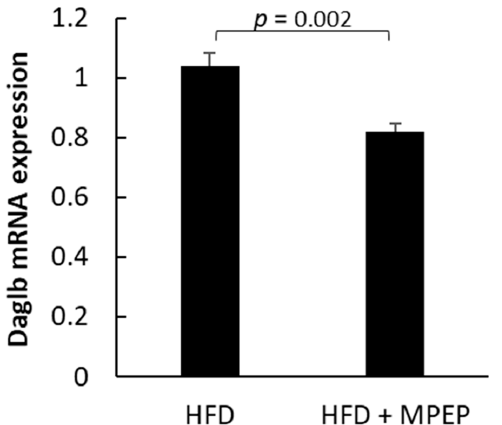
Figure 11. Hepatic stellate cell activation in obese mice. Daglb mRNA expression in liver from obese mice after 7 weeks of HFD administration, treated with MPEP 20 mg/Kg or vehicle. Results are mean ± SE of 6 individual determinations.